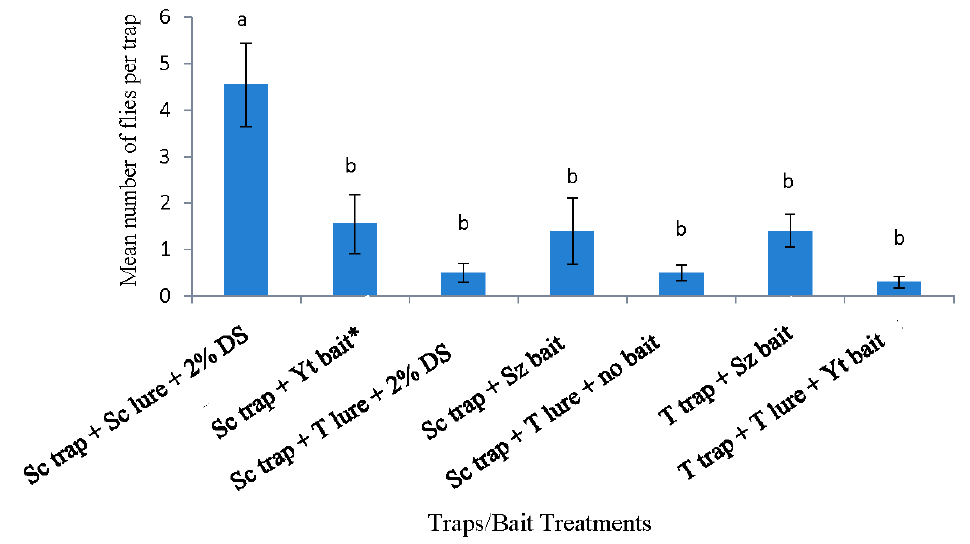
Figure 5. Drosophila suzukii adults captured in blueberry planting from 18 April 2016 to 23 May 2016 in Tallahassee, Florida. Yt = Yeast bait, T lure = Trécé lure, Sz = Suzukii trap, Sc lure = Scentry lure, and 2% DS = 2% detergent solution. * Reference treatment.